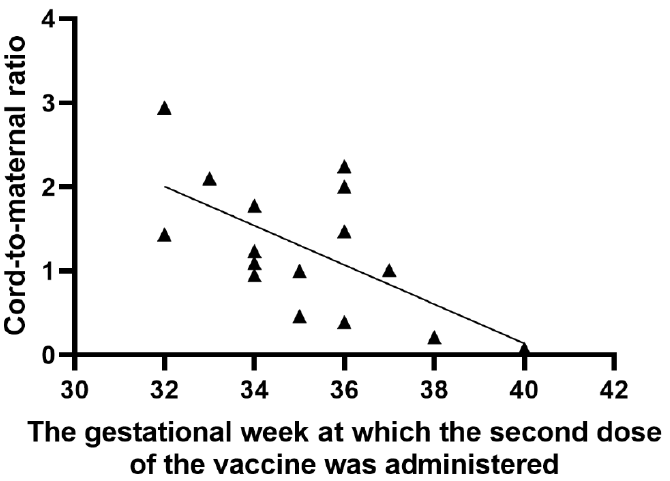
Figure 6. Correlation between the week of gestation when the first vaccine dose was administered and cord-to-maternal anti-S titer ratio.